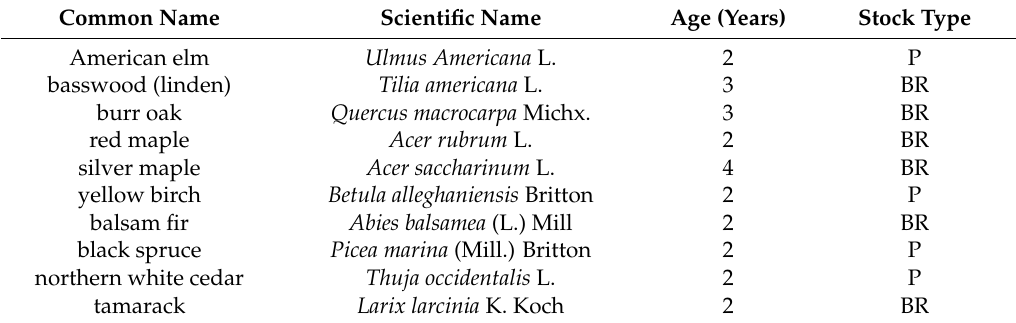
Table 2. Ottawa National Forest species and seedling ages and planting stock type (BR—bare root, P—plug).